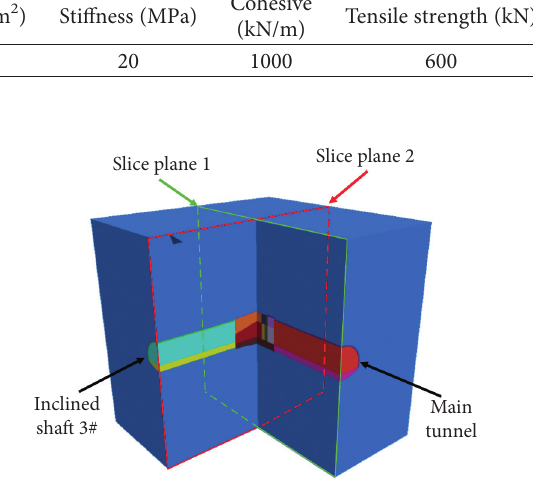
Figure 8: Location of slice